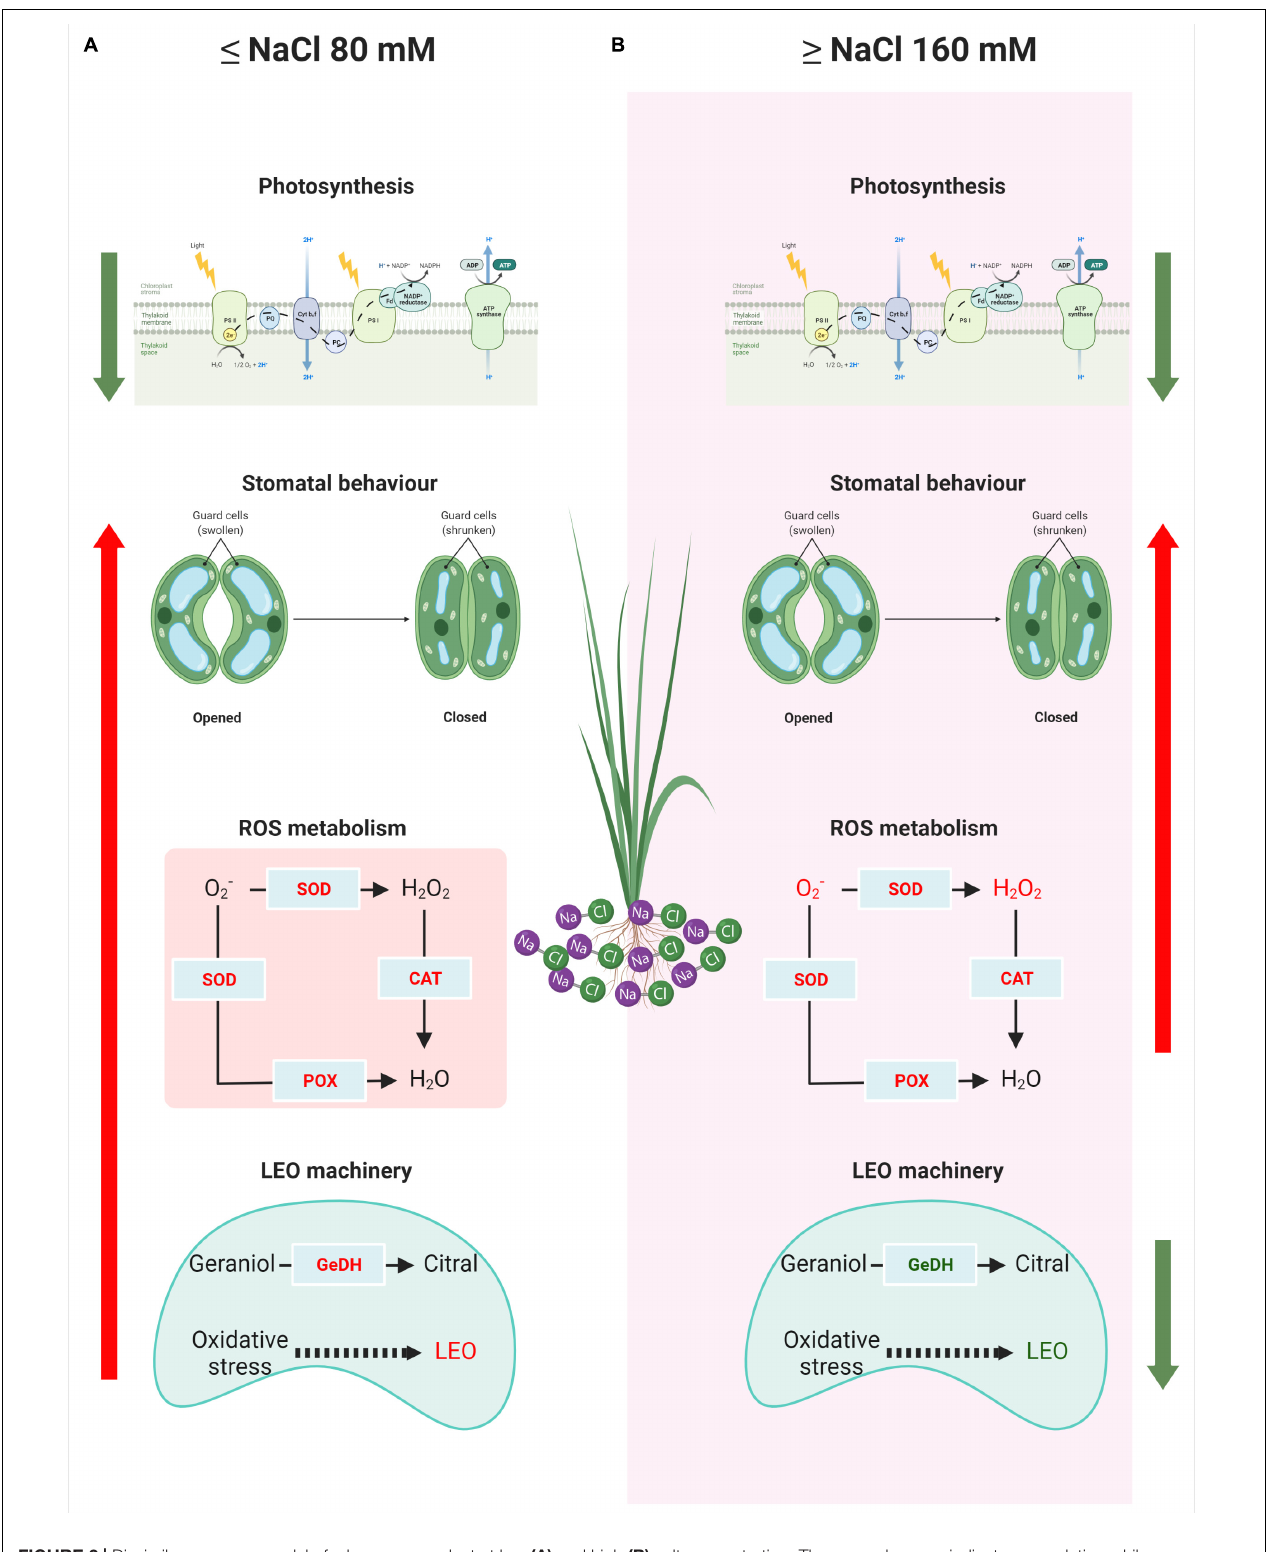
FIGURE 2 | Dissimilar response model of a lemongrass plant at low (A) and high (B) salt concentration. The upward arrows indicate upregulation while green downward arrows signify downregulation in the process. O 2 − , superoxide ion; H 2 O 2 , hydrogen peroxide content; CAT, catalase activity; POX, peroxidase activity; SOD, superoxide dismutase activity; GeDH, geraniol dehydrogenase activity; LEO, lemongrass essential oil.